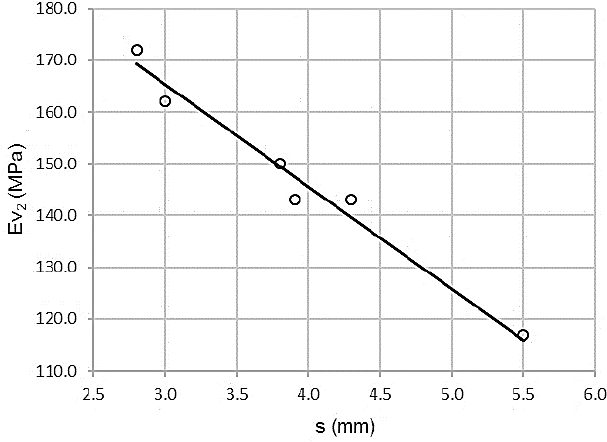
Figure 5. Topographic settlement and second modulus of PLT ( Φ 600mm) at crown.